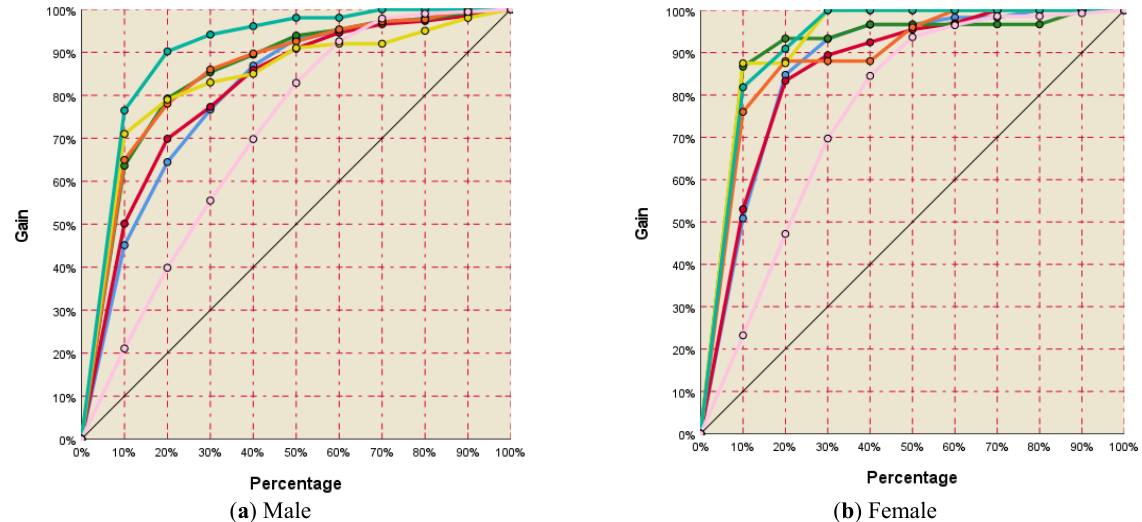
Figure 5. The gain chart for each output variable of: ( a ) male, ( b ) female.